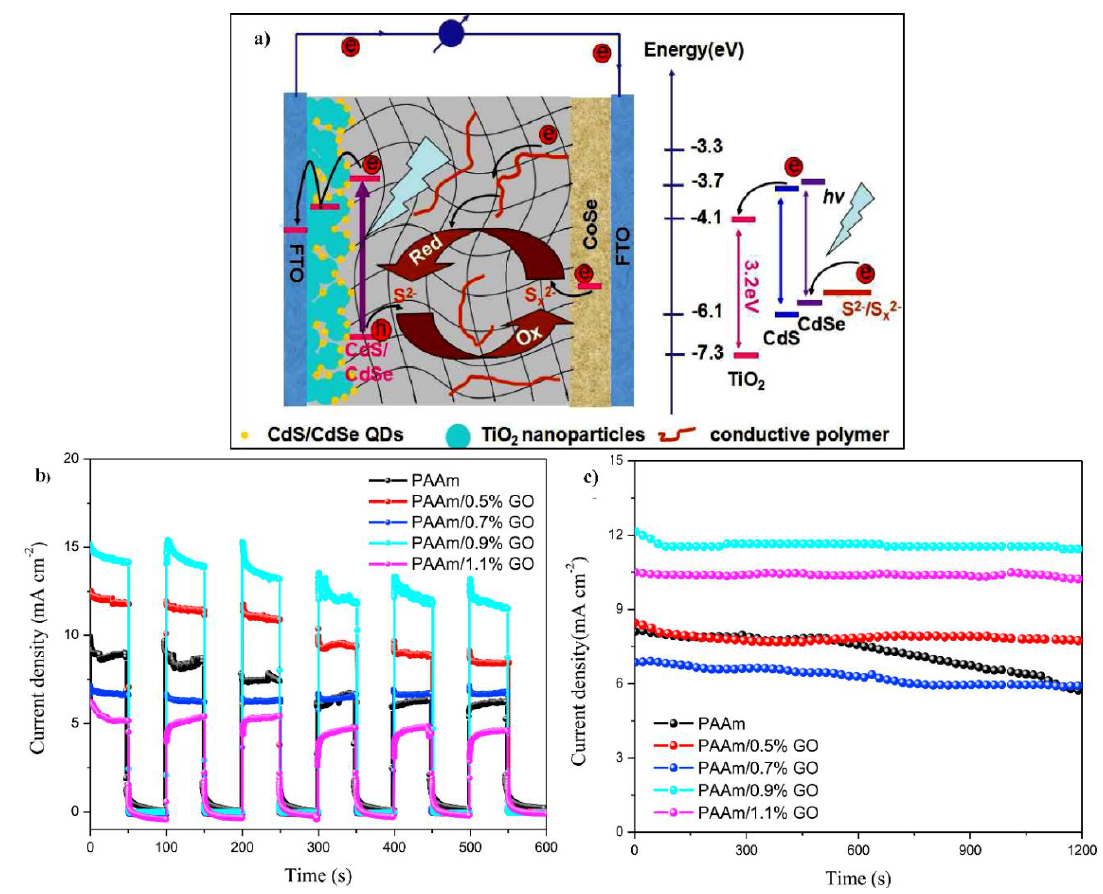
Figure 29. ( a ) The schematic diagram of a quasi-solid-state quantum dot-sensitized solar cell (QDSSC) device from a CdS/CdSe-sensitized TiO 2 photoanode and conducting hydrogel electrolytes [222]. ( b ) On–off switches and ( c ) photocurrent stability of the gel electrolyte-tailored QDSSCs [223].